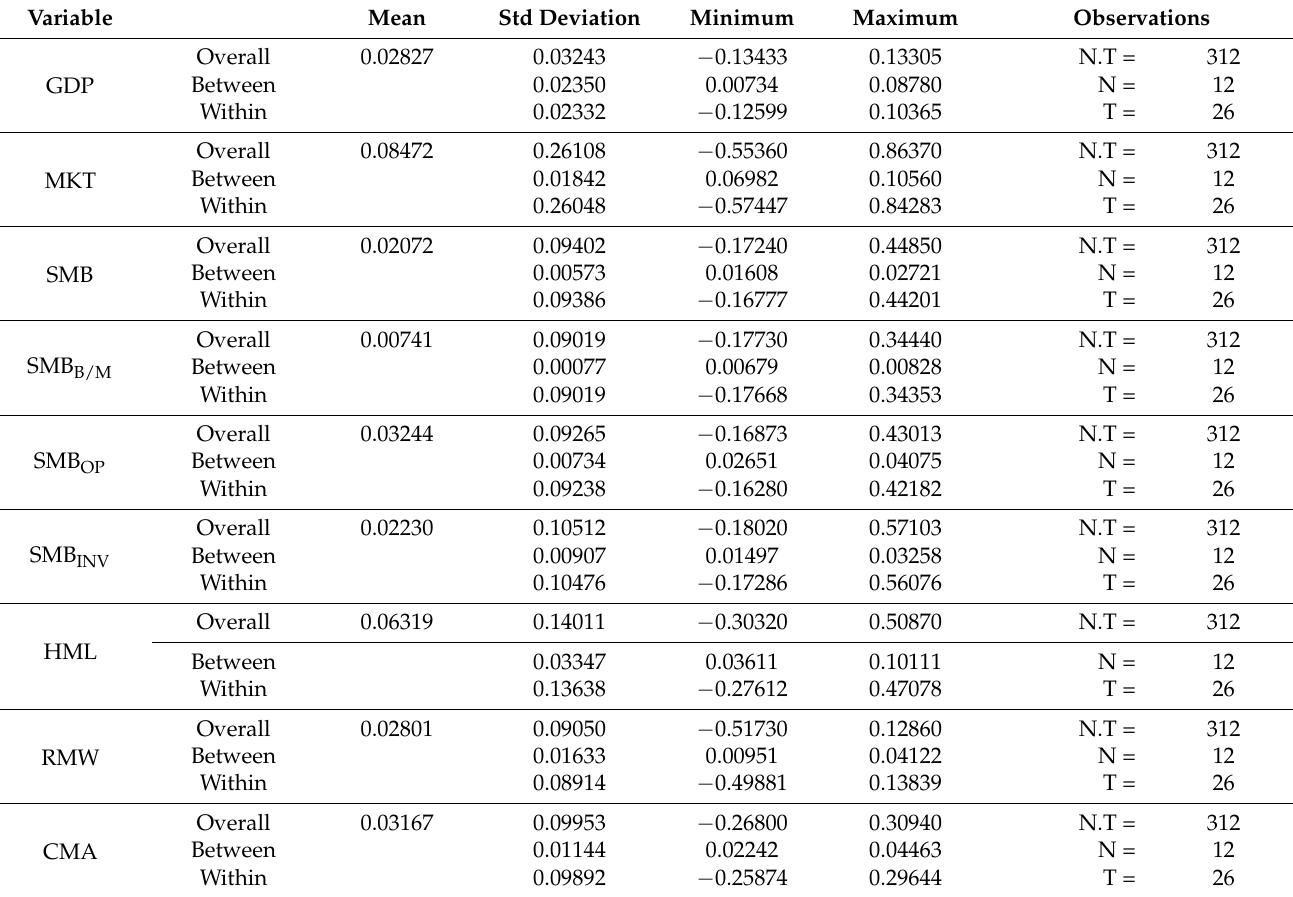
Table 3. Descriptive statistics—Decomposition of